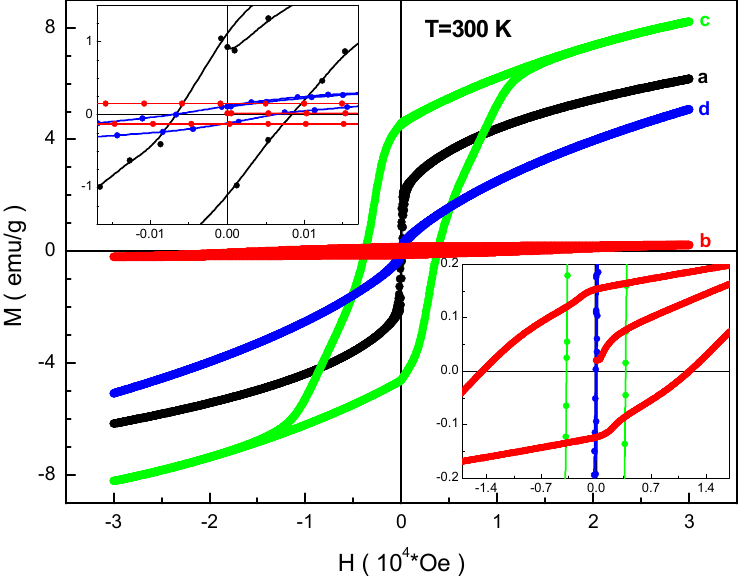
Figure 5. Field dependencies of magnetization at 300 K for the compositions ( a ) BaFe 5.84 Ga 6.16 O 19 , ( b ) BaFe 6.26 Al 2.27 Cr 3.47 O 19 , ( c ) BaFe 6.11 Al 1.56 Cr 2.17 Ga 2.16 O 19 , ( d ) BaFe 6.19 Al 1.25 Cr 1.57 Ga 1.74 In 1.26 O 19 .